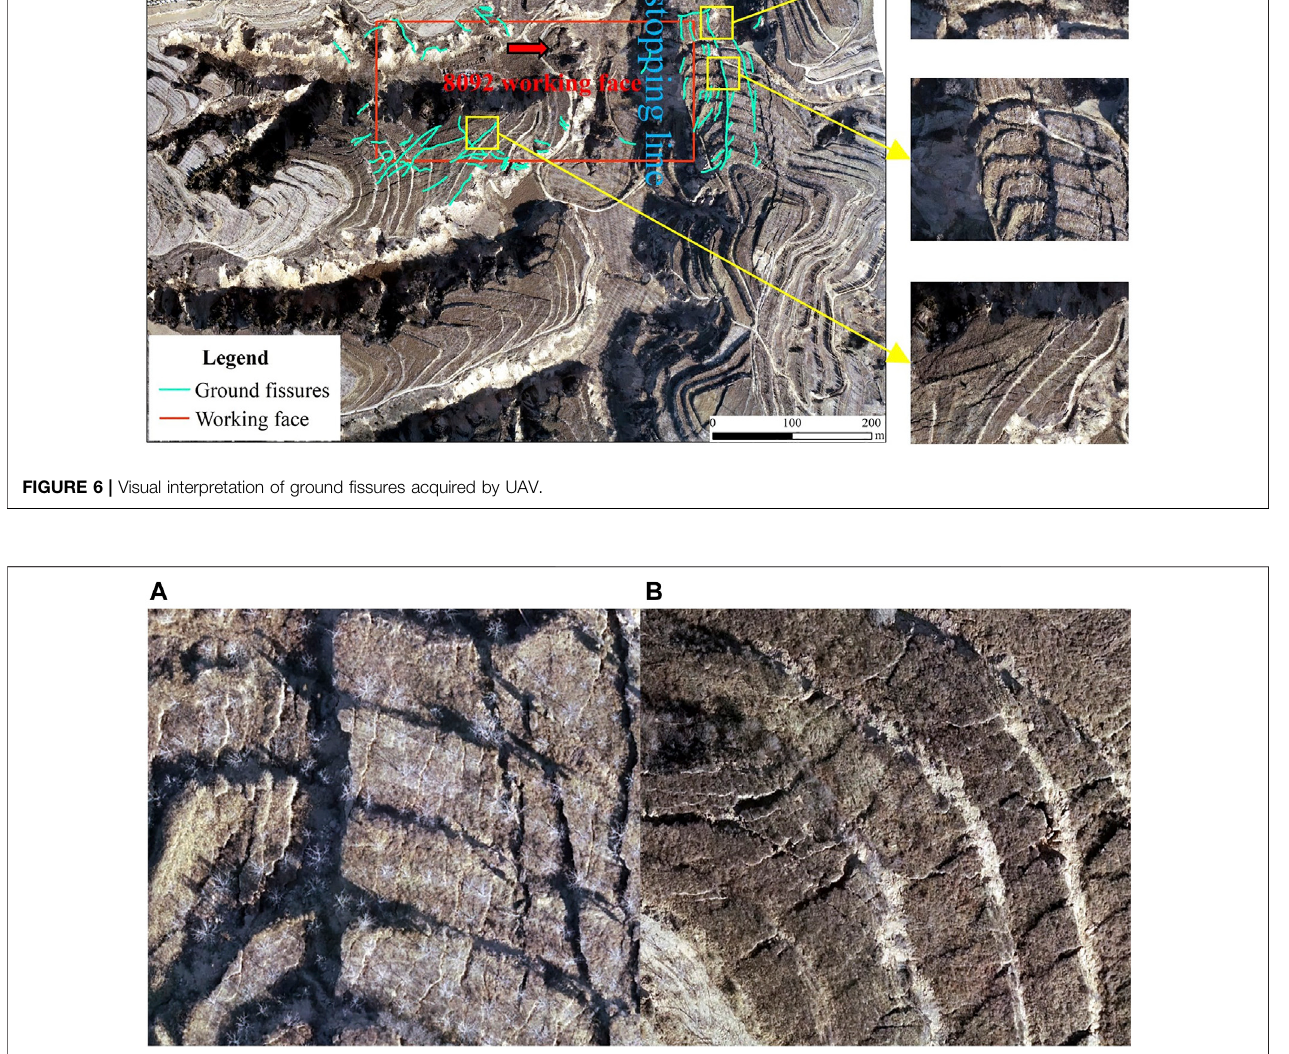
FIGURE 7 | (A) Step ground fi ssures. (B) Tensile ground fi